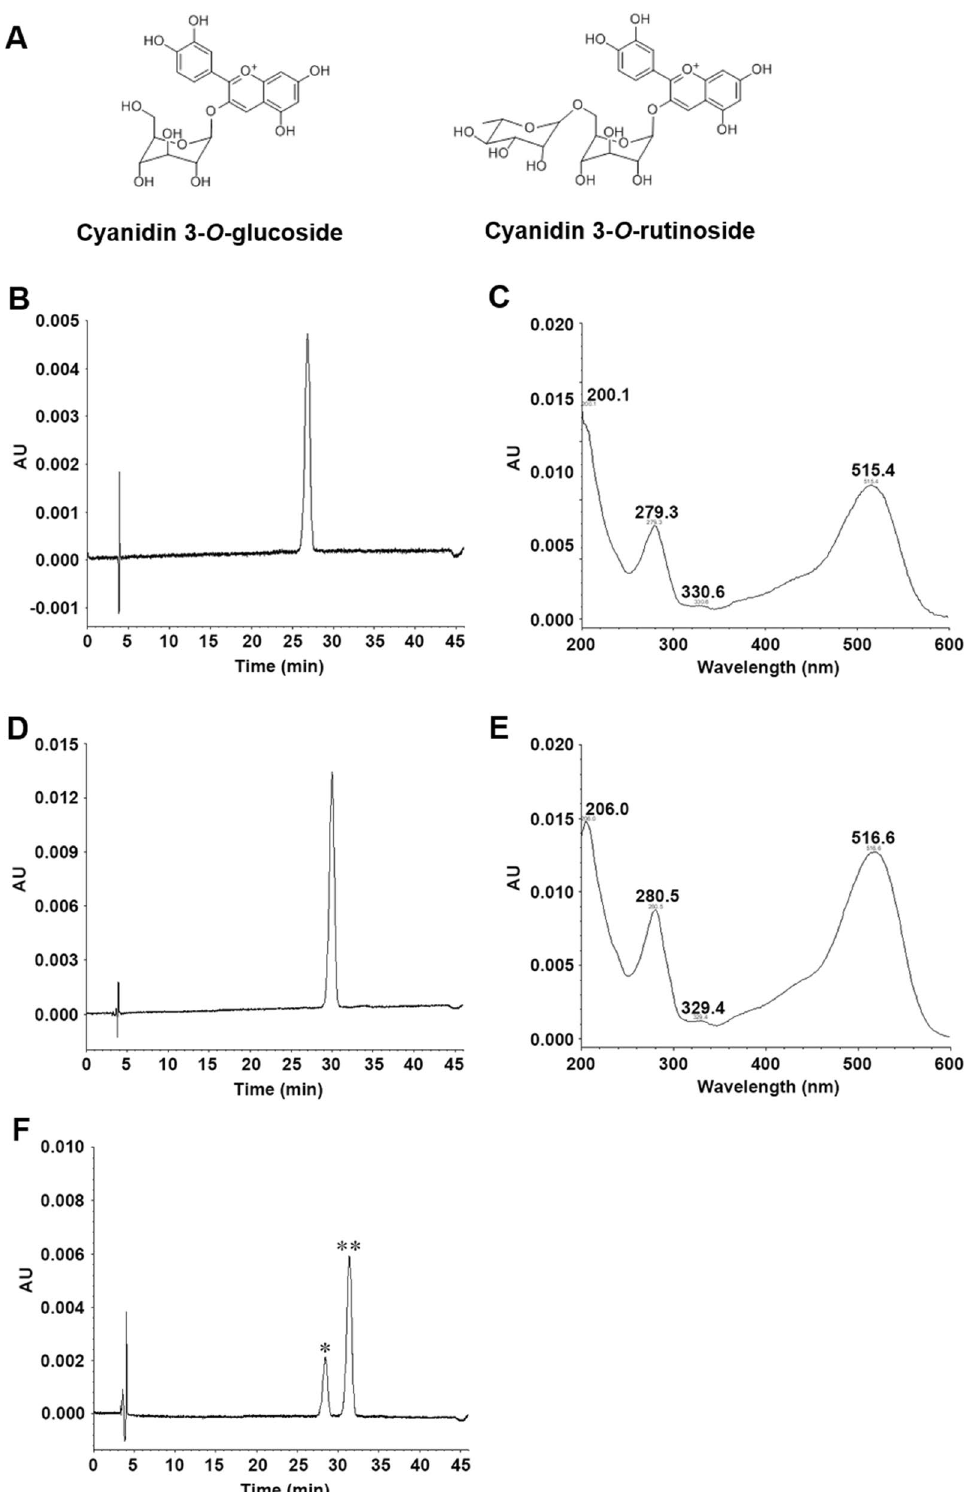
Fig. 8 Chemical structures of the anthocyanins cyanidin 3‑ O ‑glucoside (C3OG) and cyanidin 3‑ O ‑rutinoside (C3OR) ( A) . The 280 nm wavelength scan used to determine the purity of compounds 1 and 2 ( B and D ). A full‑wave scan of C3OG and C3OR ( C and E) . An HPLC c hromatogram of anthocyanin standard compounds ( F ): cyanidin 3‑ O ‑glucoside (*) and cyanidin 3‑ O ‑rutinoside